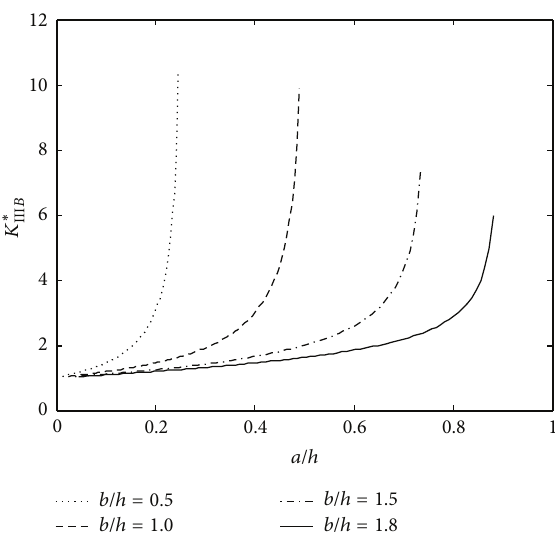
Figure 4: Various SIF of crack-tip 𝐵 with 𝑎/ℎ for 𝑏/ℎ = 0.5, 1.0, 1.5, and